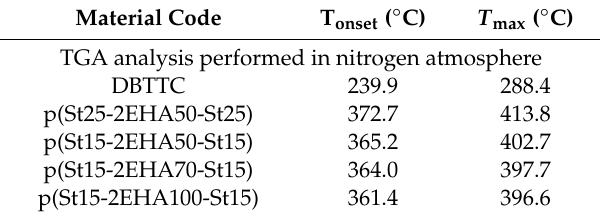
Table 3. Thermal stability of the block copolymers measured by TGA.